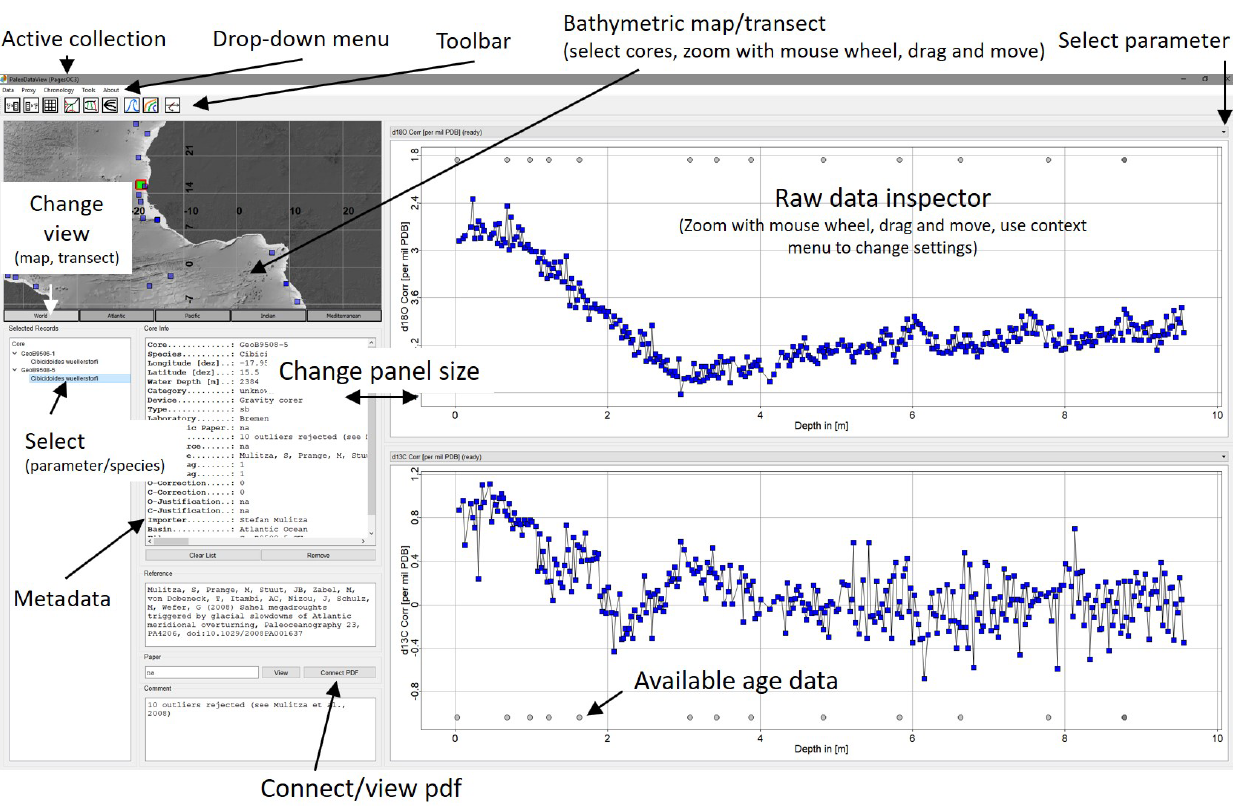
Figure 2. Main window of PDV. Core locations can be selected by pointing and double-clicking with the mouse into the map on the left panel. Both the graphics window and the map are interactively movable and scalable. Available datings/tie points are indicated by cycles at the bottom of the graph. A click on the individual data points reveals depth and isotope value. An available PDF document (i.e. from the corresponding publication) can be connected to the data set and viewed. Further functionality can be accessed through the menu or the symbol bar at the top of the